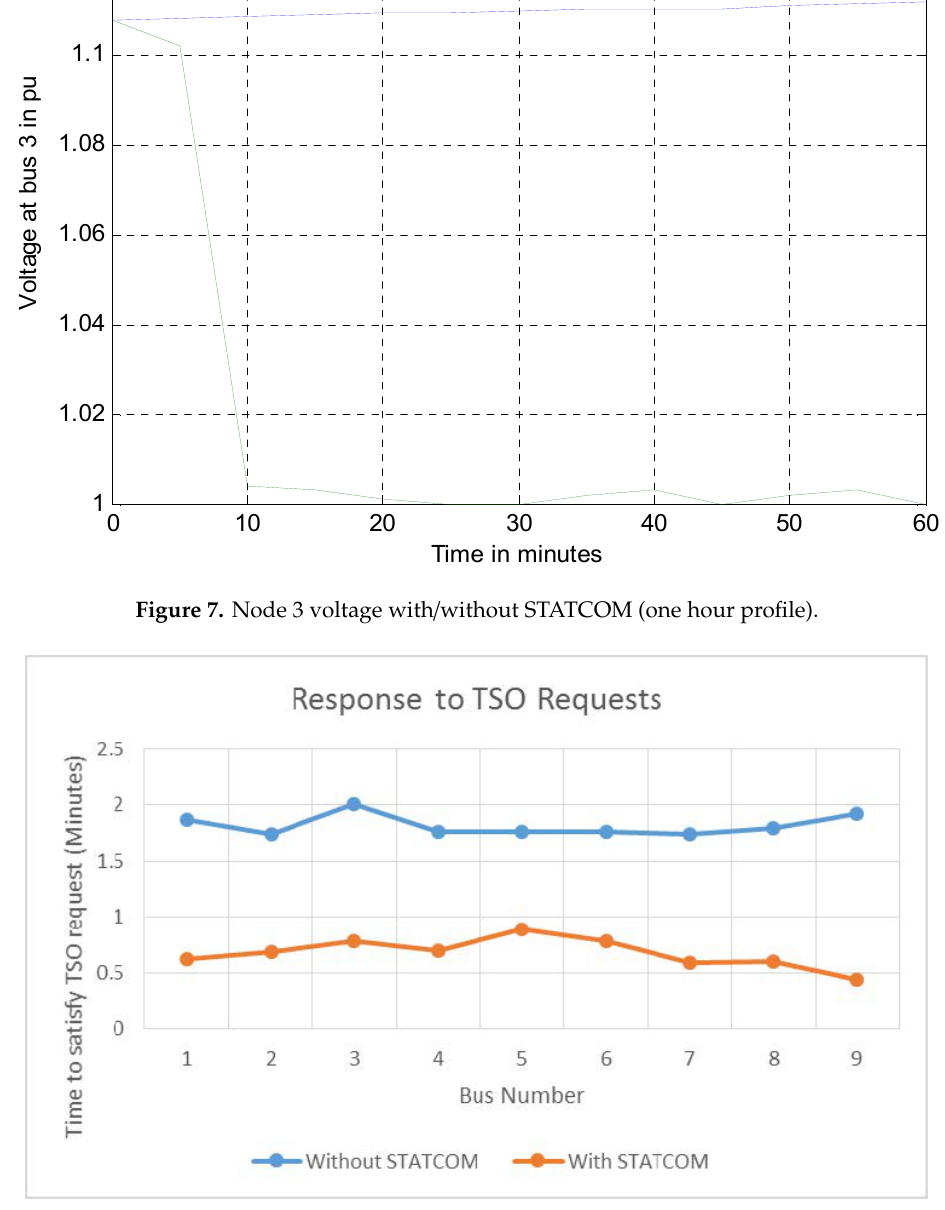
Figure 8. Response time to TSO with/without STATCOM.